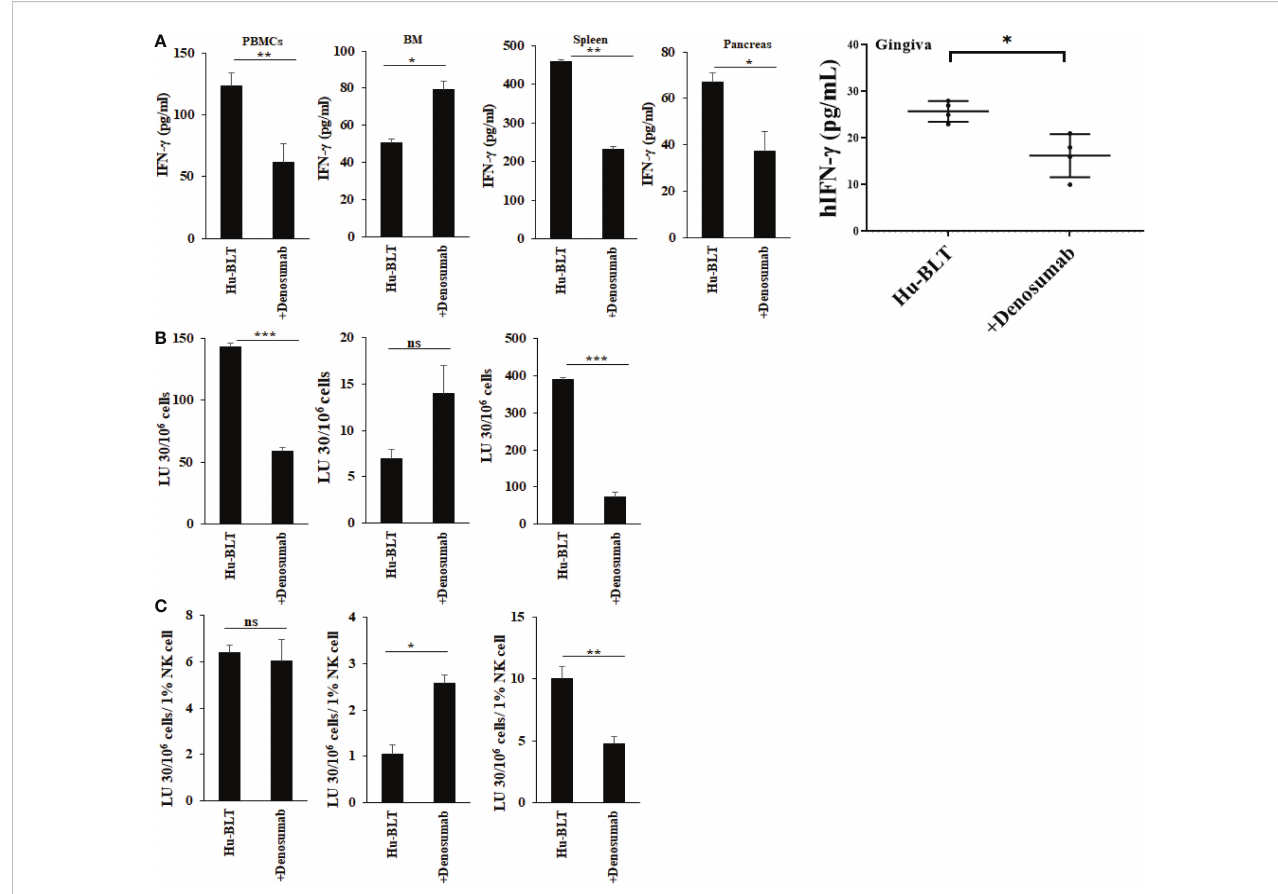
FIGURE 6 IFN- g secretion and NK-cell mediated cytotoxicity in NACL and denosumab-injected hu-BLT mice. Hu-BLT mice were administered with either 0.9% NACL or denosumab (120 mg/mice) via IV as described in Materials and Methods section. Four weeks after injections, mice were euthanized and tissues were harvested to obtain single cell suspension. PBMCs (n=2), BM cells (n=2), splenocytes (n=2), pancreas (n=2), and gingiva (n=3) of hu-BLT mice were cultured (2 × 10 6 cells/2ml) with IL-2 (1000 U/ml) for three days, after which the supernatants were harvested and the levels of IFN- g were determined using speci fi c ELISA (A) . PBMCs (n=2), BM cells (n=2), and splenocytes (n=2) were used as effector cells in standard 4-hour 51 Cr release assay against human OSCSCs tumors. Lytic units (LU) 30/10 6 cells were determined using inverse number of effector cells required to lyse 30% of OSCSCs × 100 (B) . LUs per 1% NK cells were determined using CD16+CD56+ percentages obtained by fl ow cytometric analysis (n=2) (C) . ***(p value 0.0001-0.001), **(p value 0.001-0.01), *(p value 0.01-0.05), ns (no signi fi